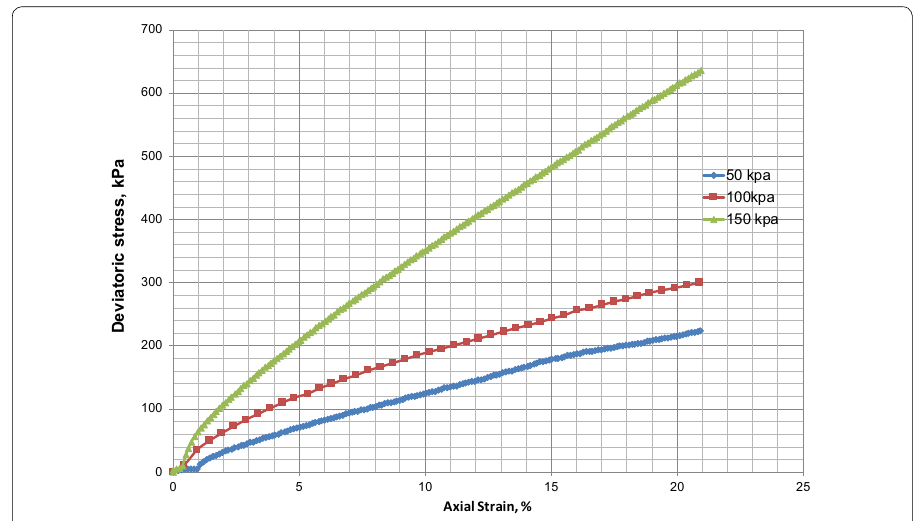
Fig. 10 Deviator stress vs. axial strain